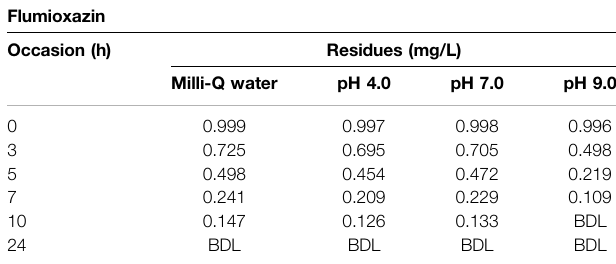
TABLE 2 | Statistical parameter details of fl umioxazin at 0.01 and 0.1 µg/mL forti fi cation levels in Milli-Q water. Statistical parameters (6 replications)